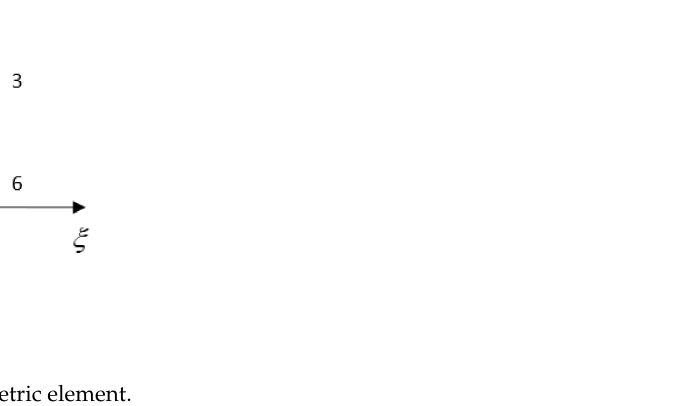
Figure 3. 9-Noded isoparametric